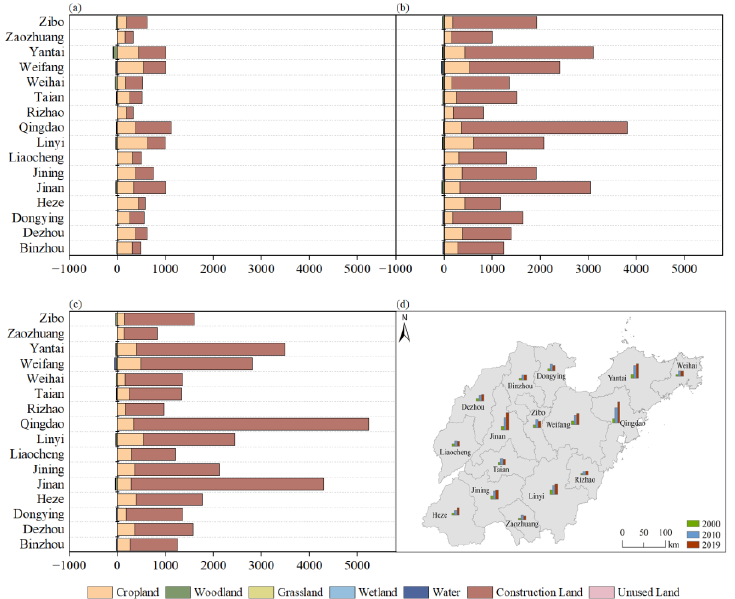
Figure 5. Carbon emissions of 16 cities in Shandong Peninsula urban agglomeration (unit: 10 7 kg). ( a ) Carbon emissions from different land uses in 2000; ( b ) carbon emissions from different land